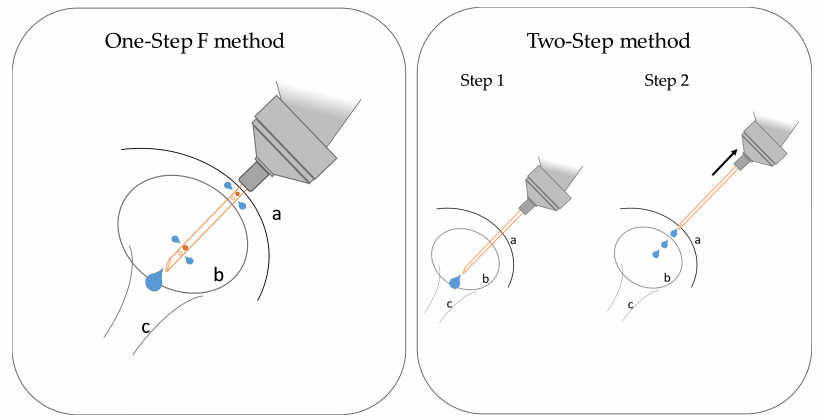
Figure 1. Schematic overview of the one-step F and two-step methods. a—Scrotal skin, b—testis, c—Spermatic cord. One step F method: the needle was inserted caudally to its full length so that the distal opening and the distal lateral opening were positioned in the testicle and the proximal lateral opening was arranged in the subcutaneous tissue of the scrotum. A total of 0.6 mL of a local anesthetic was administered. Two-step method: Step (1) the needle was inserted for approximately three-fourths of its length and a volume of 0.4 mL of the local anesthetic was intratesticularly injected. Step (2) The needle was withdrawn, and a volume of 0.2 mL was evenly distributed over the injection